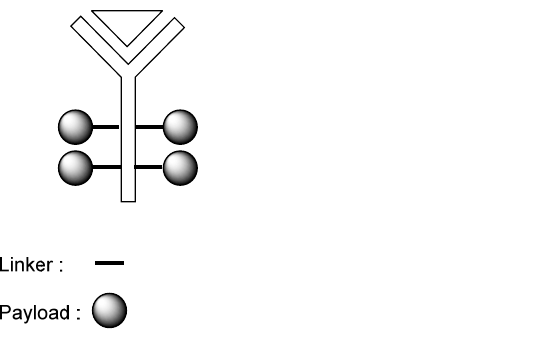
Figure 1. Cartoon illustrating the structure of an antibody–drug conjugate (ADC) drug.